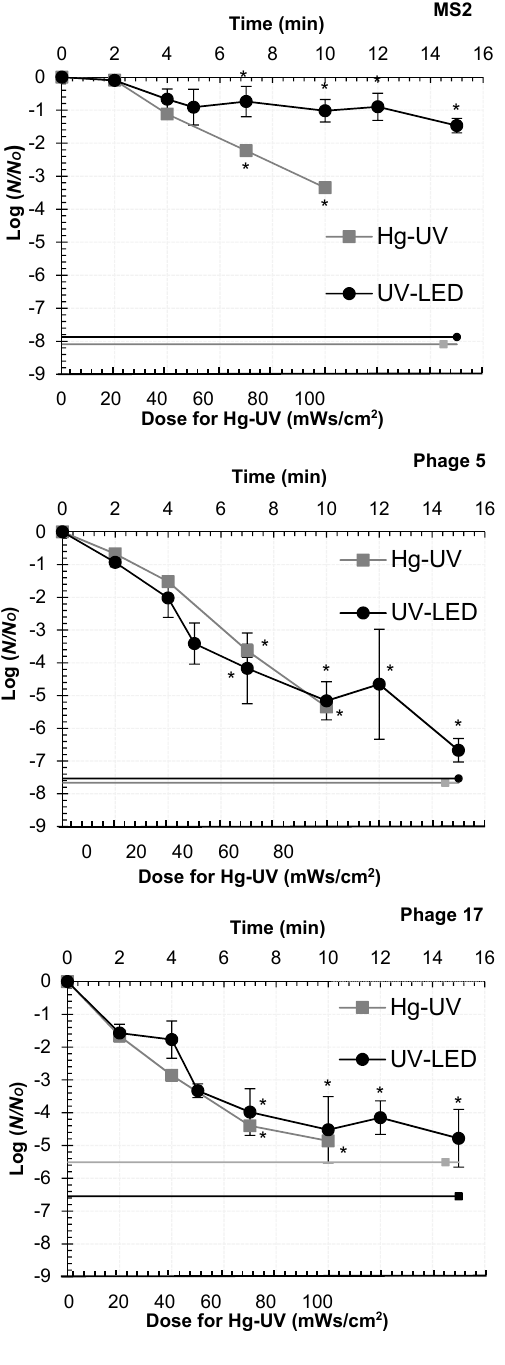
Figure 2. Inactivation of MS2 and four UV ‐ and/or Cl ‐ resistant coliphages (1, 5, 7 and 17) with Hg ‐ UV and UV ‐ LED treatment. Statistically significant differences from the control (UV dose 0 mWs/cm 2 ), assessed by related sample Friedman’s two ‐ way analysis of variance, are indicated with asterisks, * p < 0.05. The lines show the theoretical maximal Log 10 ‐ reductions for each coliphage. For Hg ‐ UV and for UV ‐ LEDs.